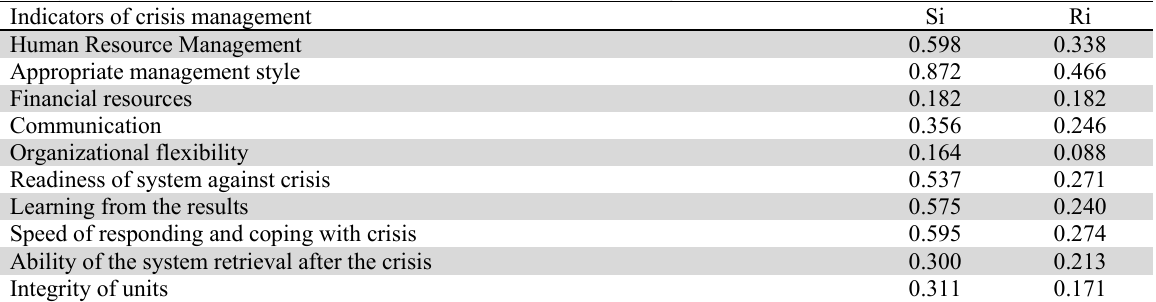
Utility values and the maximum and minimum values of regret